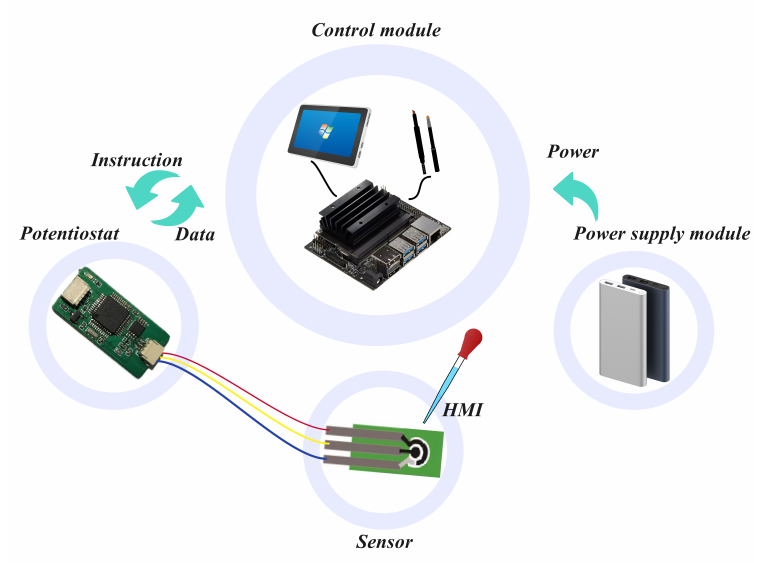
Figure 1. Block diagram of the electrochemical hardware system.